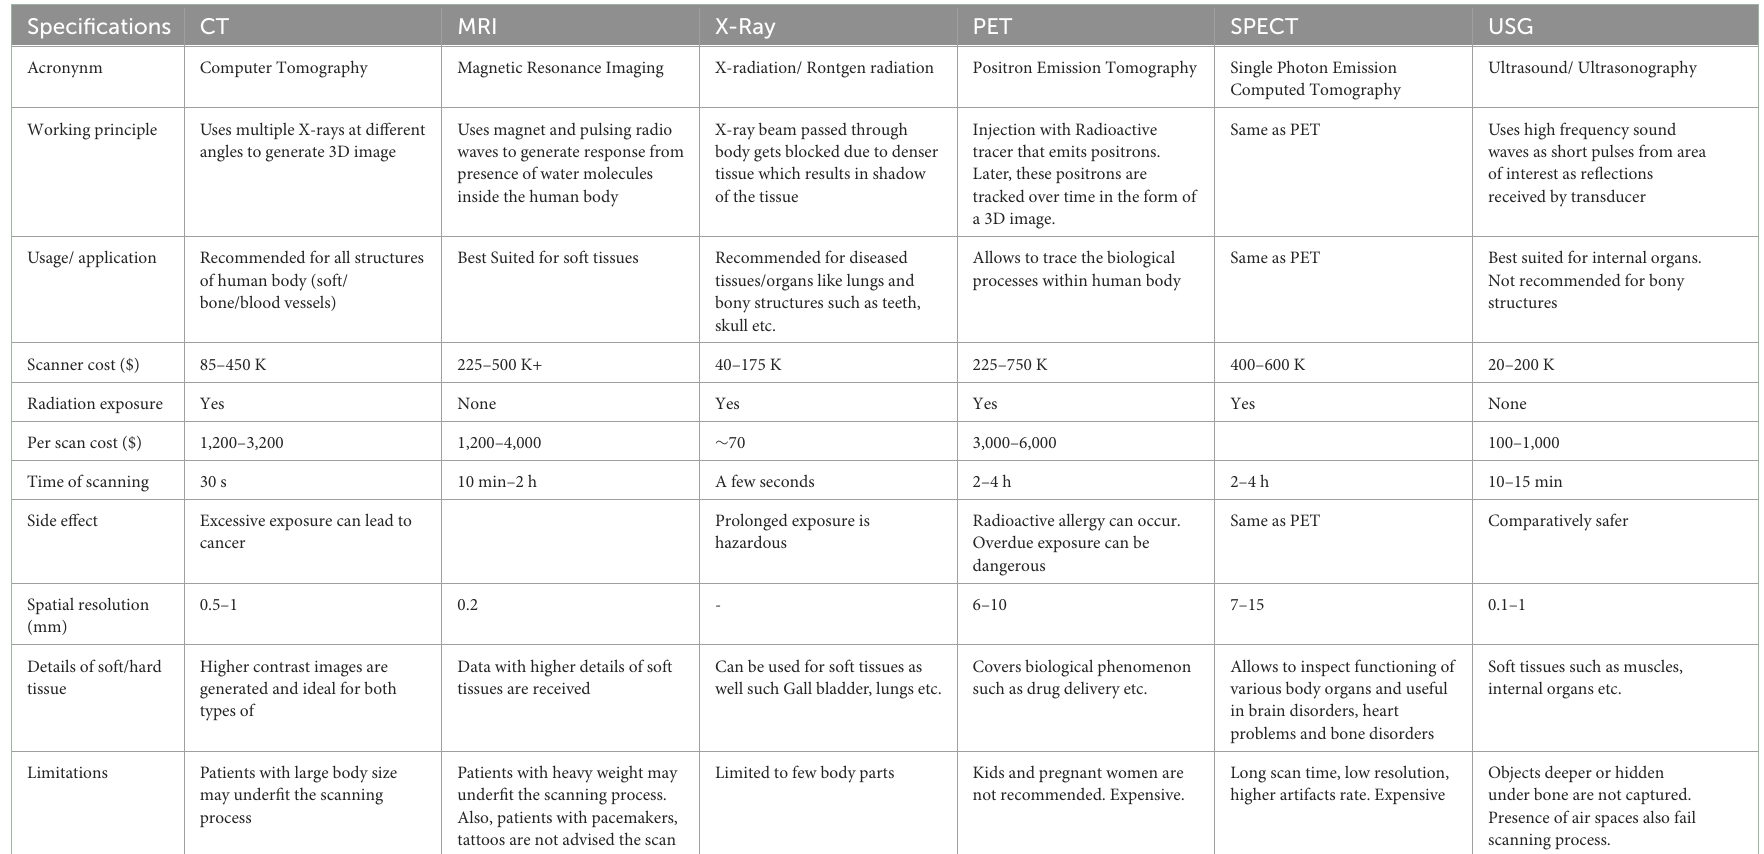
TABLE 1 Comparative analysis of common and widely used imaging modalities for medical